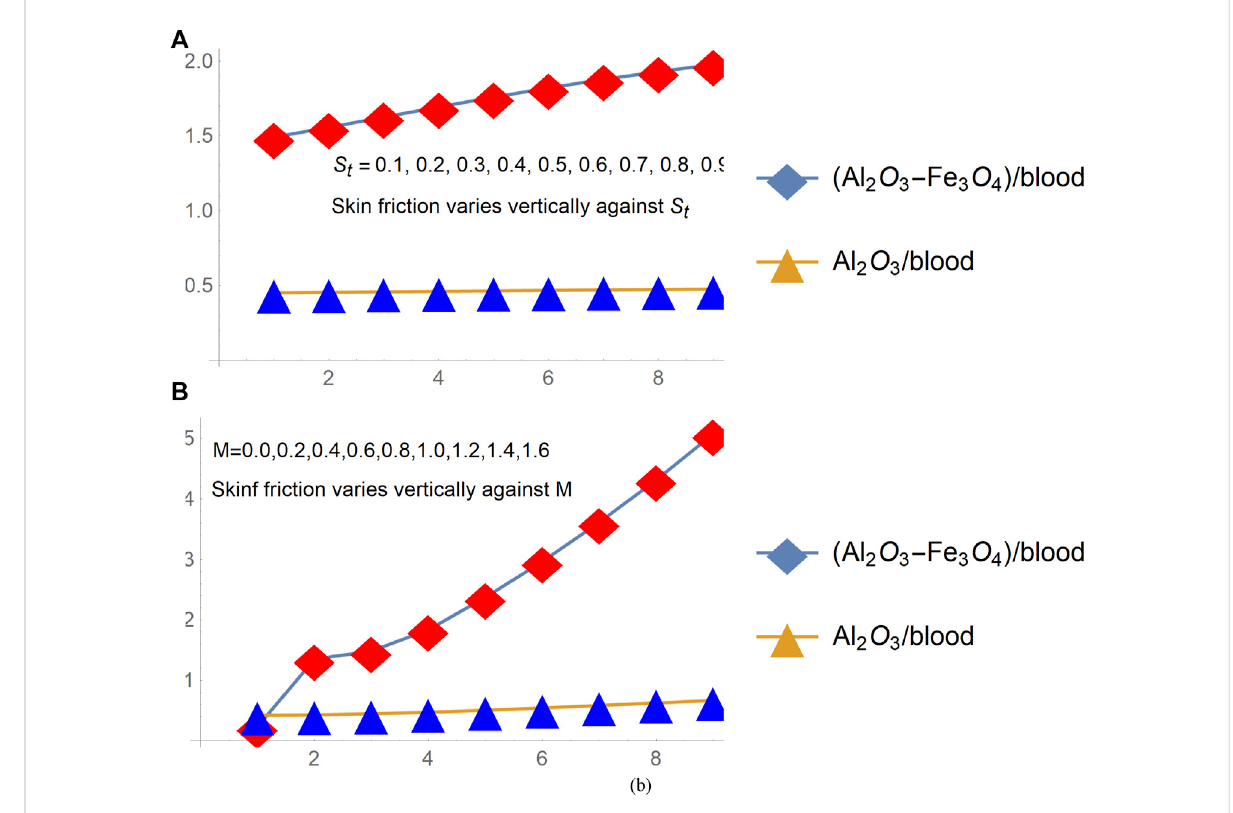
Skin friction changes under varying (A) S t (stretching parameter) and (B)